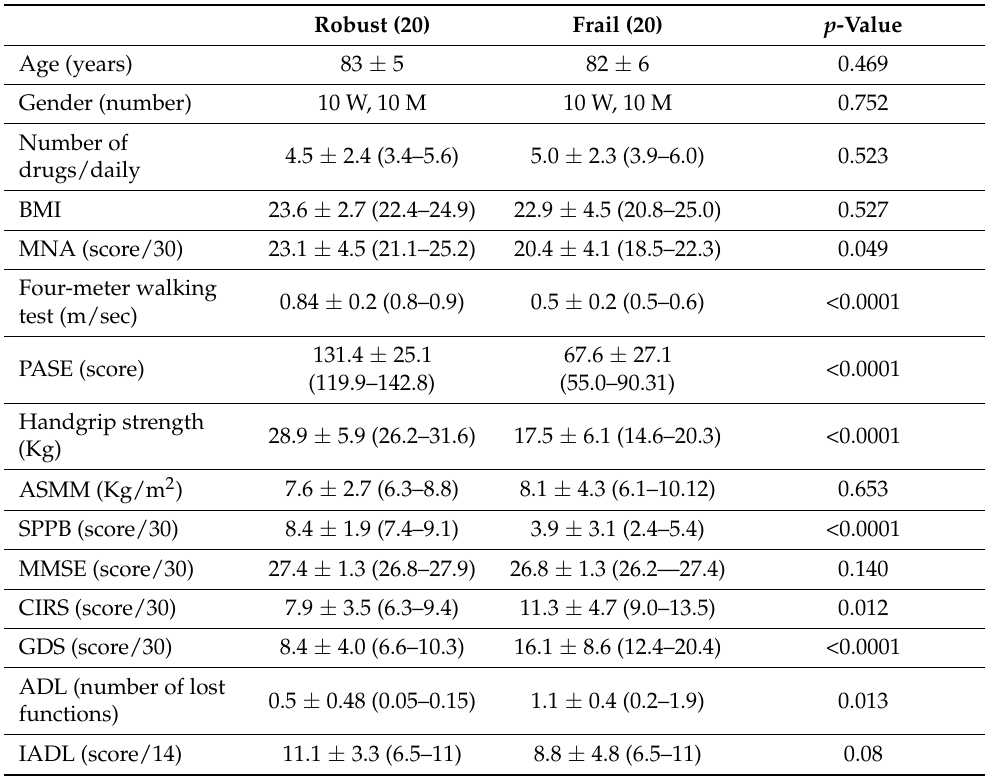
Table 1. General characteristics of the subjects according to the diagnosis of frailty. Mean and SD values with CIs are shown; p -values were calculated by one-way ANOVA. Robust (20) Frail (20) p -Value 83 ±